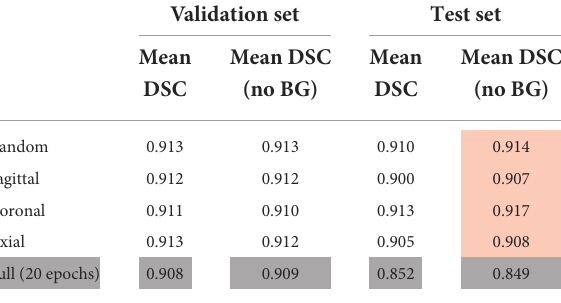
TABLE 3 Mean DSC values of the four budgeting conditions. Validation set Test set